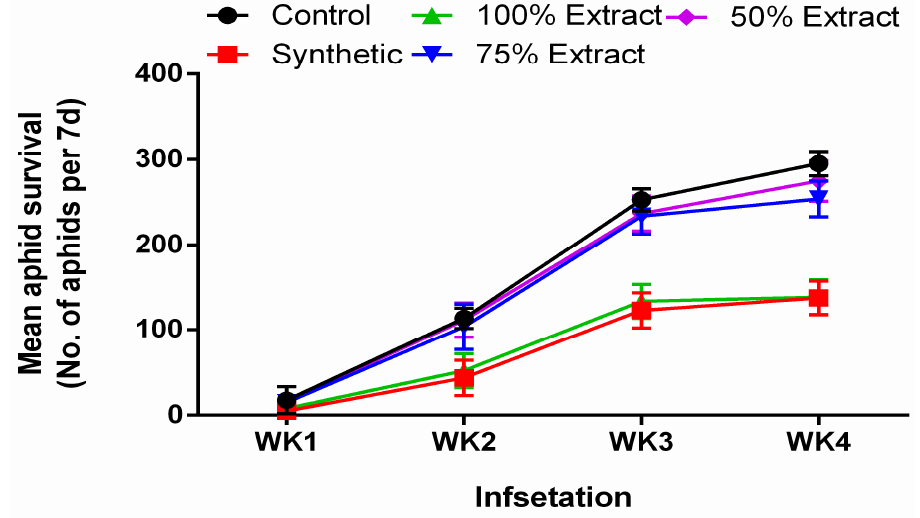
Figure 1. The effect of potato leaf extract on mean aphid survival. Data represent the mean ± standard deviation of three replicates. Note: synthetic pesticide (recommended rate of Beta cyperme- thrin).